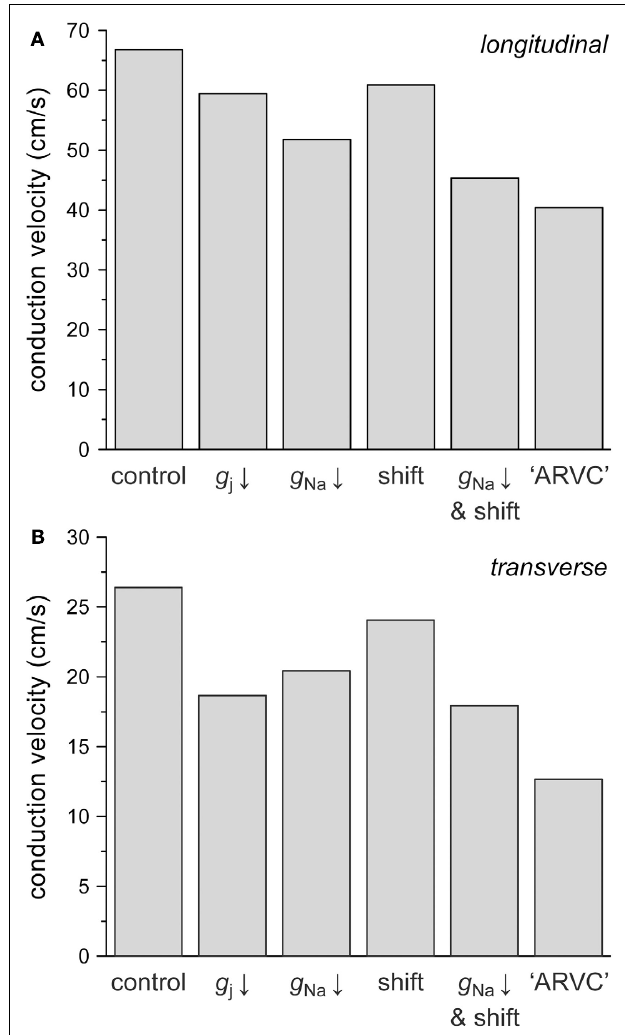
FIGURE 8 | Effect of a 50% decrease in gap junctional conductance (labeled “ g j ↓ ”), a 50% decrease in sodium current conductance (“ g Na ↓ ”) or a − 15mV shift in the I Na steady-state inactivation curve (“shift”), as implicated inARVC, on (A) longitudinal and (B) transverse conduction velocity. Also shown are the combined effects of a 50% decrease in g Na and a − 15mV shift (“ g Na ↓ and shift”) and the combined effects of a 50% decrease in g j , a 50% decrease in g Na and a − 15mV shift